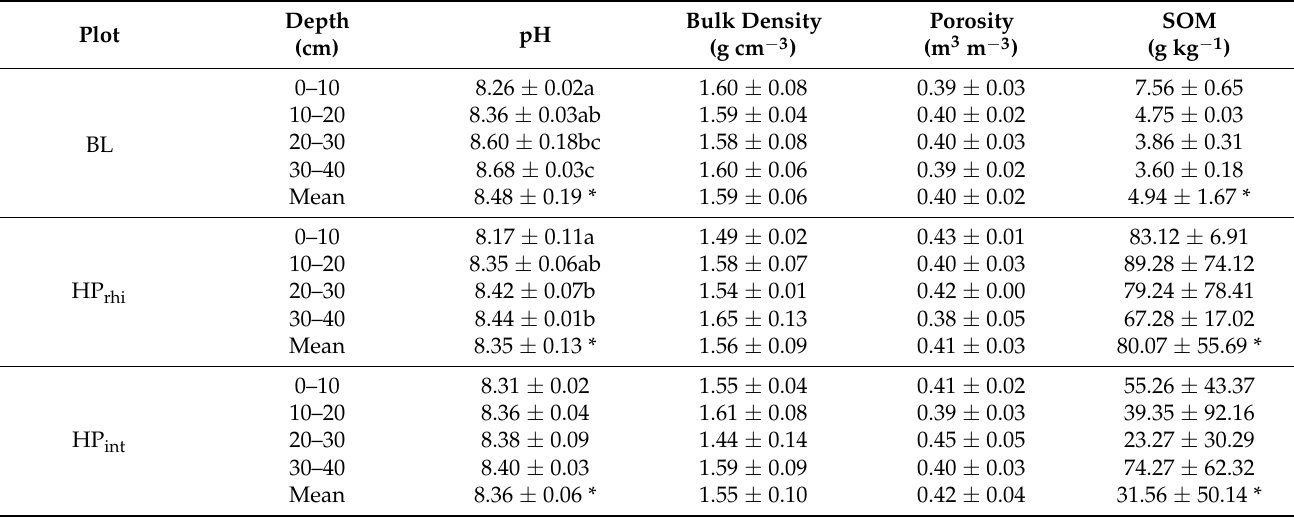
Table 1. Soil pH, bulk density, total porosity, and SOM content in BL and HP plots.